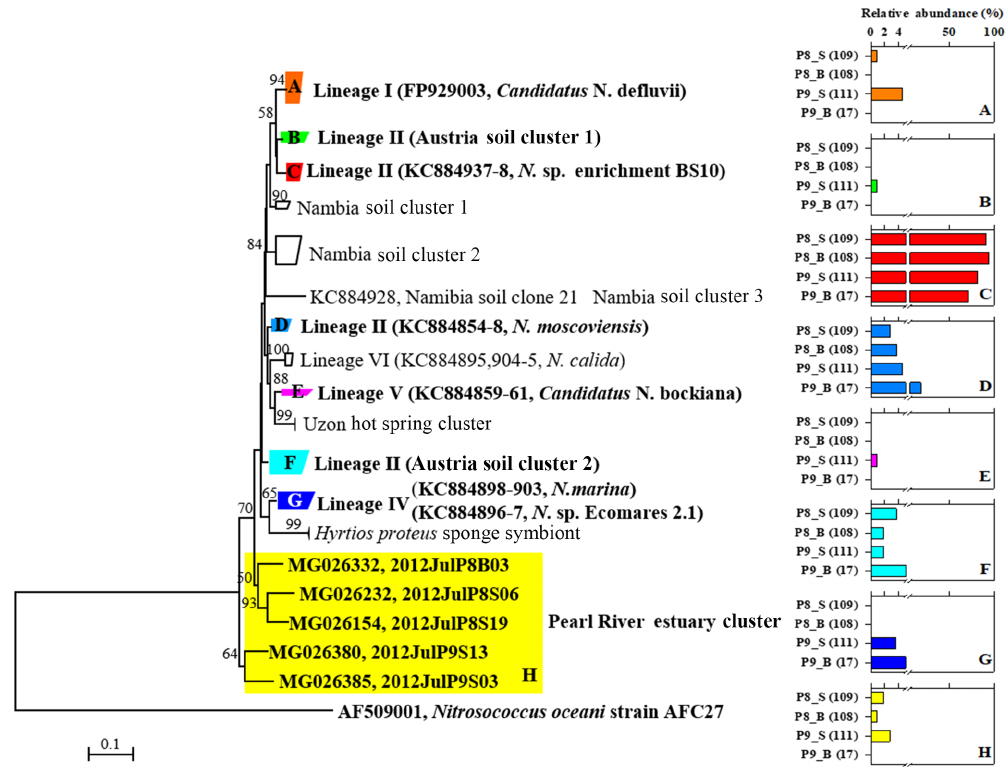
Figure 4. Rooted neighbor-joining (NJ) phylogenetic tree of the Nitrospira nxr B gene sequences. Clone sequences from this study are shown in bold, and sequences sharing 95% DNA identity are grouped. GenBank accession numbers are shown. Groups A, B, C, D, E, F, and G are defined according to Pester et al. (2013), and group H (highlighted in yellow) is defined in this study. The relative abundance of clones retrieved for each library in the eight subgroups is indicated by a bar. Total number of clones for each library is shown in parentheses. Location of sites P8 and P9 (S and B indicate surface and bottom waters, respectively) is shown in Fig. 1. Phylogenetic relationships were bootstrapped 1000 times, and bootstrap values greater than 50% are shown. The scale bar indicates 10% estimated sequence